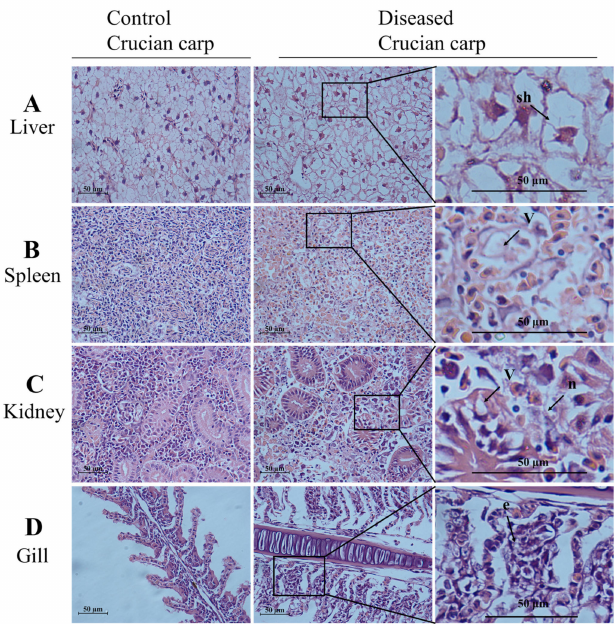
Figure 2. Histological differences in the liver, spleen, kidney, and gill of the diseased crucian carp and control fish (healthy fish). Samples of liver, spleen, kidney, and gill from the diseased fish and the control fish (healthy fish) were fixed, embedded, sectioned, and stained with hematoxylin and eosin (HE). The slides were examined with light microscopy. Scale bars = 50 µ m. ( A ) Swelling of hepatocytes (sh) marked by an arrow; ( B ) the arrow shows vacuolation (v); ( C ) focal necrotic lesions (n) and vacuolation (v) were present on the kidney of the diseased crucian carp; ( D ) the arrow shows the exfoliation of epithelial cells